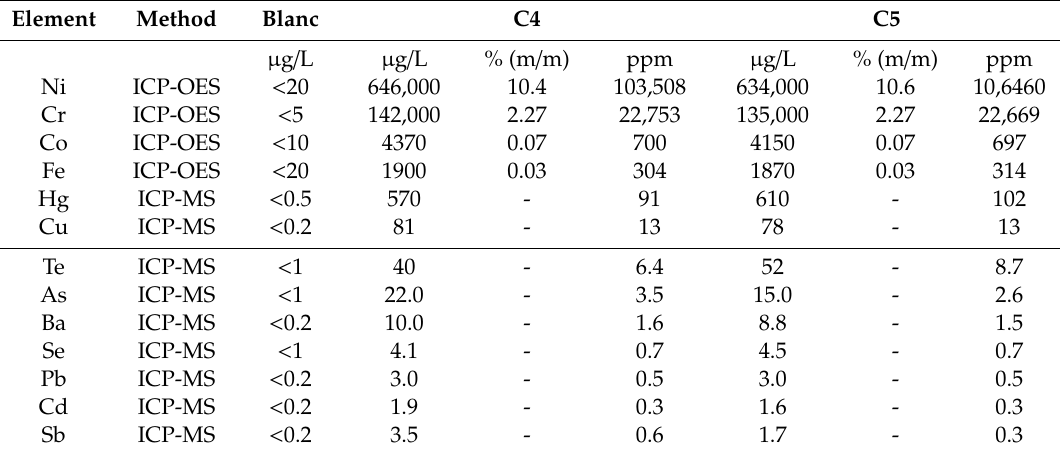
Table 4. Inductively coupled plasma(ICP) analysis of the